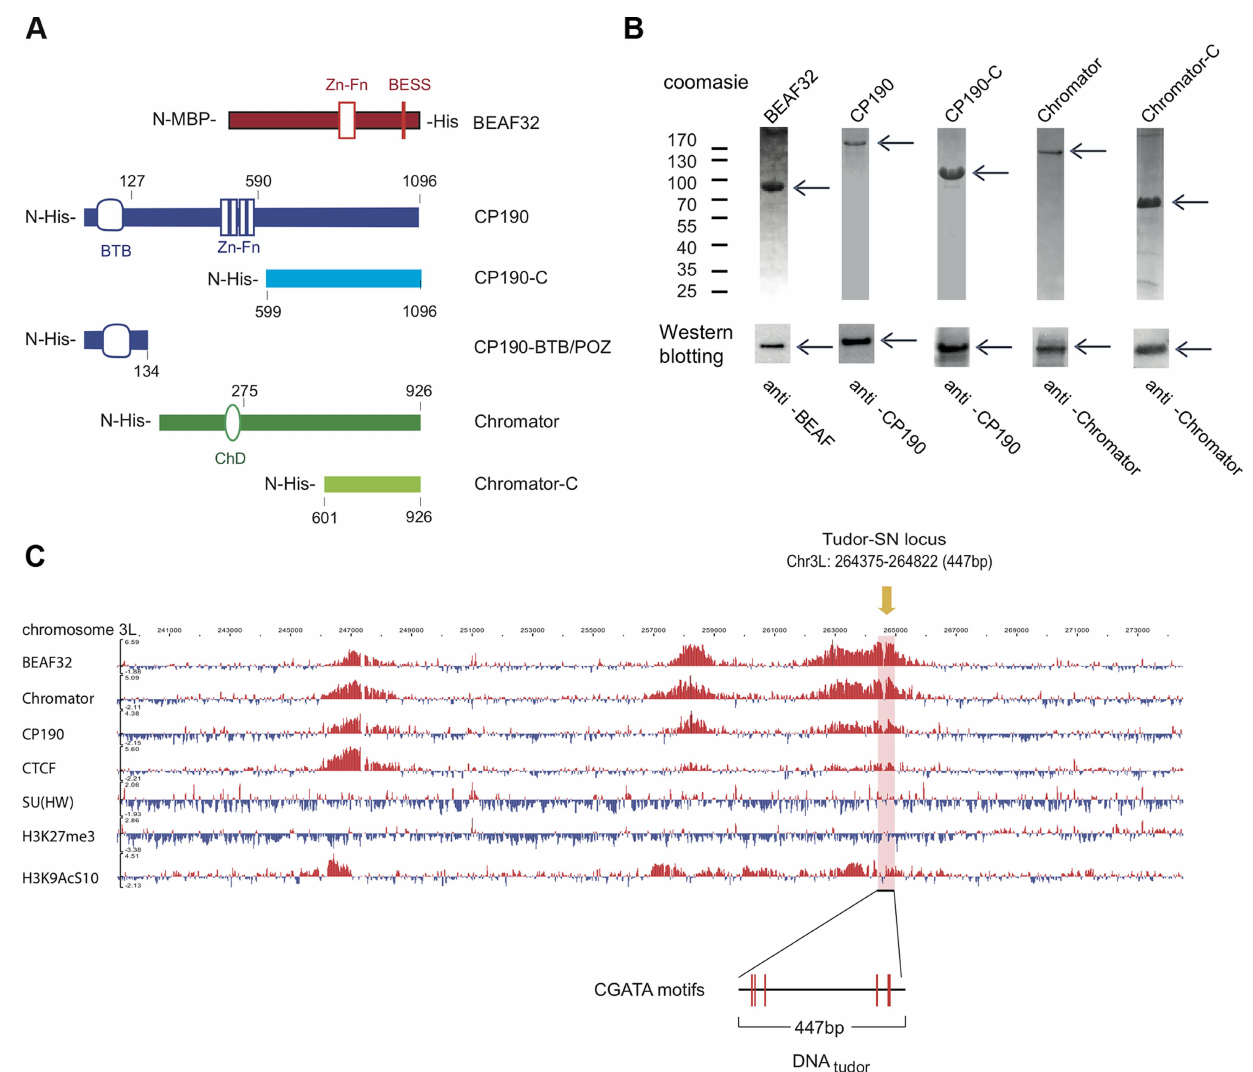
Figure 1. Protein constructs, protein purification, and genomic localization of insulator proteins and associated factors. (A) Description of protein constructs used in this study. C2H2 zinc-finger motifs (Zn-Fn) are shown as vertical rectangles, BESS motifs as a vertical red line, BTB/POZ domains as rounded boxes and chromo-domains (ChD) as ellipses. N-terminal domains (N-) are always on left. Lengths of each domain or fragment is indicated in number of amino-acids from the N-terminal end. His indicates a 6-Histidine tag, and MBP the maltose binding-protein. (B) Purity of purified BEAF32, CP190, CP190-C, Chromator, and Chromator-C was assessed by poly-acrylamide gel electrophoresis (PAGE, Coomassie blue staining, top panel), and resulted in single bands ( . 95% purity, see arrows). Molecular weight ladder is shown on the left. Western-blot analysis (bottom panel) of each purified protein shows the specific recognition by each of the antibodies developed. (C) Binding profile of insulator-associated proteins (BEAF32, Chromator, CP190, dCTCF, Su(HW)) and epigenetic marks (H4K27m3, and H3K9AcS10) in chromosome 3L from ModEncode data (S2 cells; Generic Genome Browser version 2.40). Tracks used are described in Supplementary Table S6. For each protein, the track depicts the MAT score of each probe plotted on the y-axis versus chromosomal position plotted along the x-axis. The genomic region used for EMSA-analysis (DNA tudor , part of the Tudor-SN lucus) is highlighted in pink (3L: 264375–264822). DNA tudor contains six CGATA binding motifs.